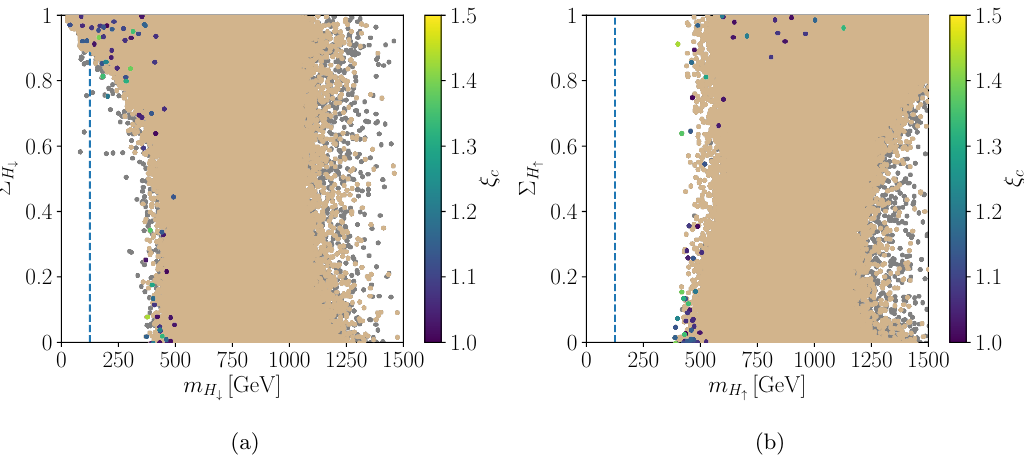
Figure 9 . N2HDM T2: Left: singlet admixture (cid:6) H color code is the same as in (cid:12)gure 3. The color bar indicates the strength of the phase transition for (cid:24) c 1. The di-Higgs search constraints are included. The blue dashed line indicates the SM (cid:21) Higgs mass value of m h 125 (cid:25)